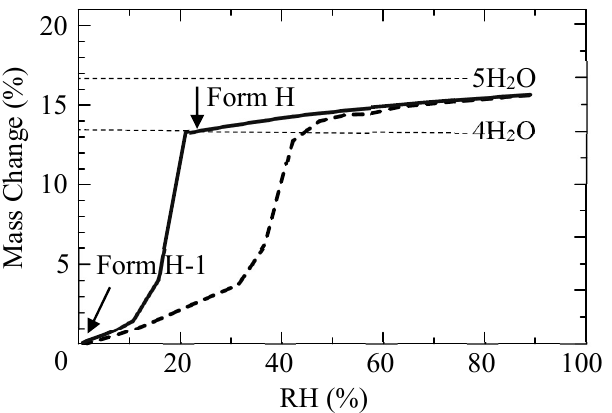
Figure 6. Emission isotherm of water pertaining to Form H (solid curve) and absorption isotherm of water pertaining to Form H-1 (dotted curve)